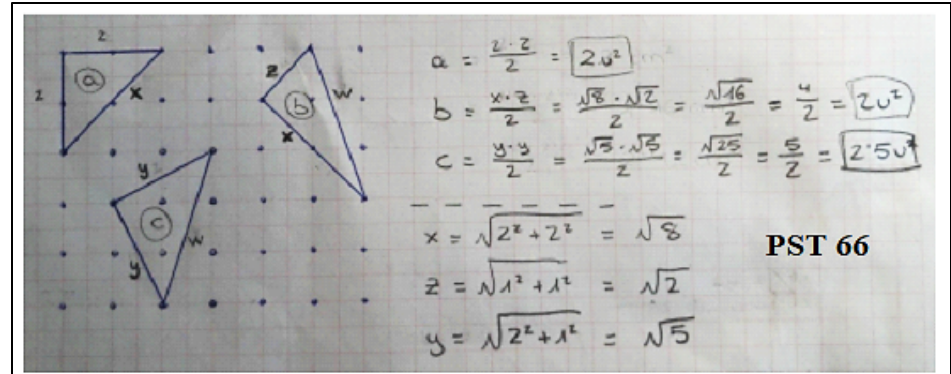
Figure 12. Example of a resolution process followed by PST